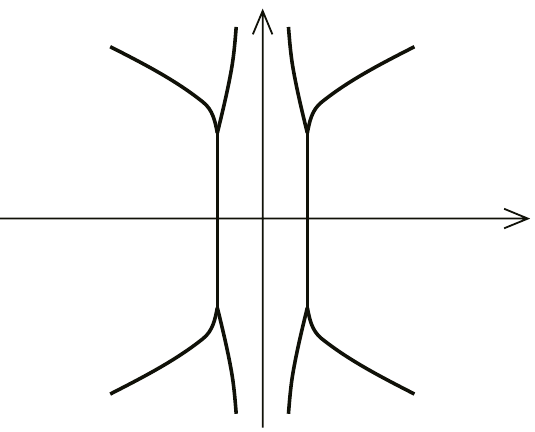
Figure 13 . The Stokes lines for the fermion preheating when “crossing” is not